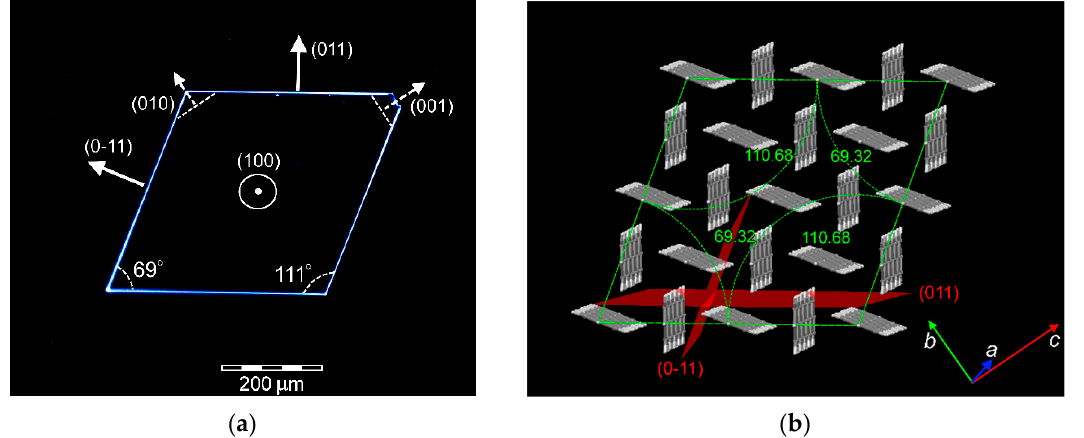
Figure 9. ( a ) Image of p-quinquephenyl single crystal under UV light with schematic representation of the growth directions and ( b ) schematic representation of a compact rhombic molecular cluster in a (100) layer.